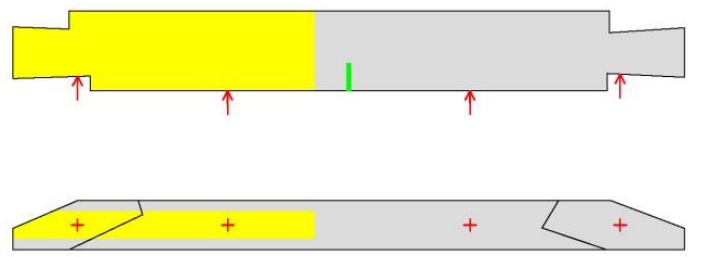
Figure 24. A scheme of the extent of the rot, beam (I2) (yellow—replacement, grey—standard wood density without the need of repair). Arrow and + marking points measured with Resistograph.